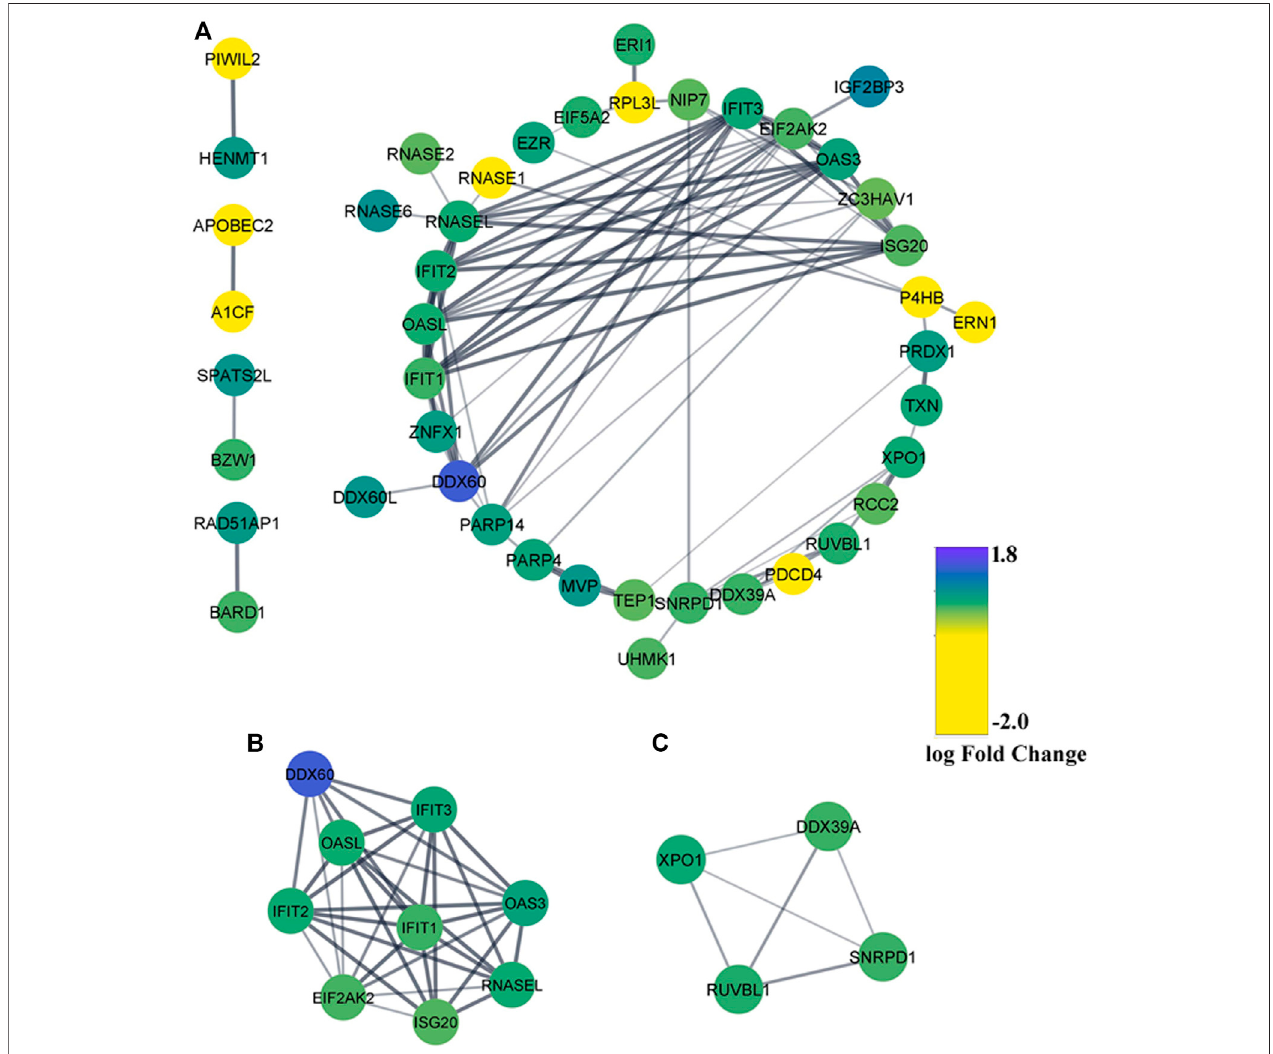
FIGURE 4 | Protein – protein interaction (PPI) network of the differentially expressed RBPs. (A) PPI network of DE-RBPs constructed using the STRING database. RBPswithoutanyinteractionwithanotherDE-RBPareremoved.BluedenotesupregulatedDE-RBPsandyellowdenotesdownregulatedDE-RBPs. (B,C) TwoMCODE modules from the PPI